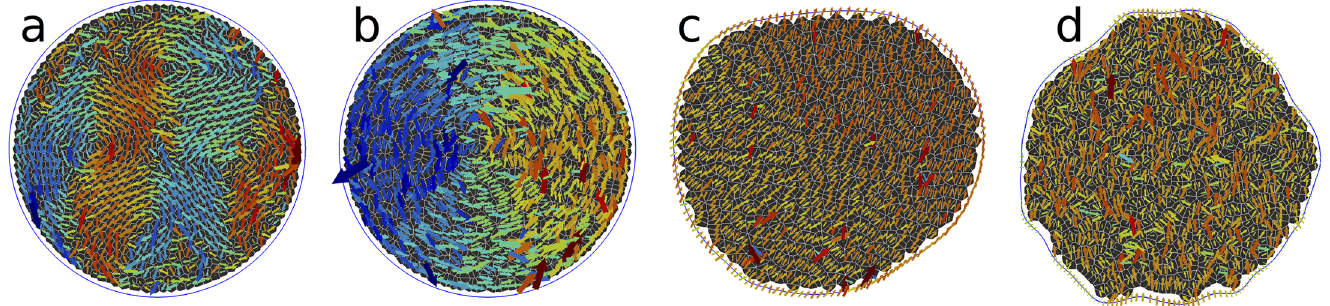
Fig 10. Effects of alignment. (a-c) are self-alignment of the cell polarisation with the cell velocity. (d) is self-alignment of the cell polarisationwith the long ¼ 0 : 01 ), at alignment strength J v = 1.0 shows oscillatingcollective axis of the cell. (a) A confinedsystem in the solid-likeregion( f a = 0.03, p 0 = 3.385, t (cid:0) 1 r ¼ 0 : 1 ), the system enters a vortex rotation state instead( J v = 1.0). (c) An open system at f a = 0.1, modes. (b) In the liquidregion( f a = 0.1, p 0 = 4.4, t (cid:0) 1 r ¼ 0 : 1 , boundaryline tension λ = 0.1 and J v = 0.1 migrates collectively.(d) An open system at f a = 0.1, p 0 = 3.95, t (cid:0) 1 ¼ 0 : 1 , boundaryline p 0 = 4.4, t (cid:0) 1 r r tension λ = 0.1 and alignmentwith cell shapewith J s = 1 migrates collectivelywith complex fluctuations. Arrows are cell velocity vectors v i ; they are coloured by the magnitude of v x for (a) and v y for (b-d). Orange is positive (pointingright/upwards) and blue is negative(pointingleft/downward).